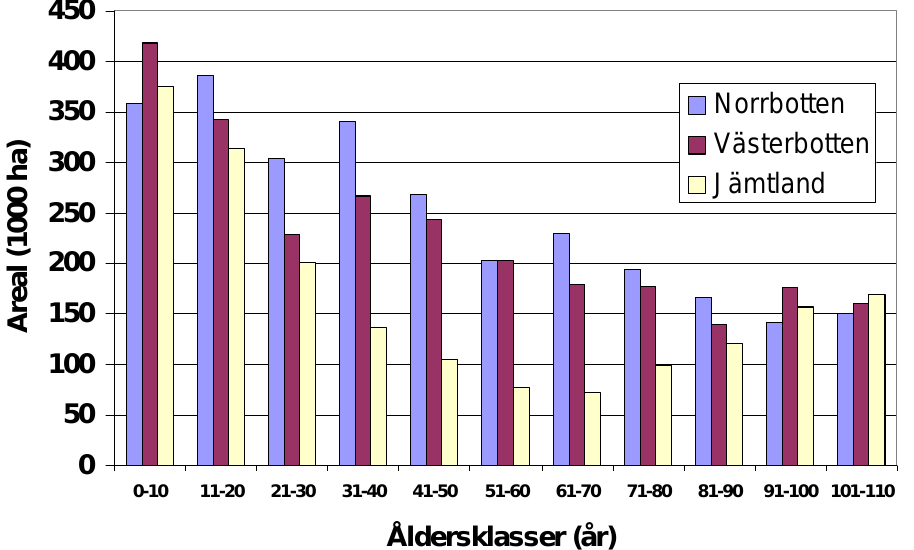
Skogens åldersklassfördelning i renskötsellänen i Sverige 1996-2000. Lämpliga för betning är främst åldersklasser över 30-40 år. Åldersklasserna över 50 år är förhållandevis opåverkade av skogsodlingen som påbörjades under 1950 och 1960-talen, men motsvara bara ca 20 års avverkningar med den avverkningstakt som gällt de senaste 20 åren. Det innebär att de snabbt kan bli tagna i anspråk för skogsodling och därmed utgå som primär betesresurs för en